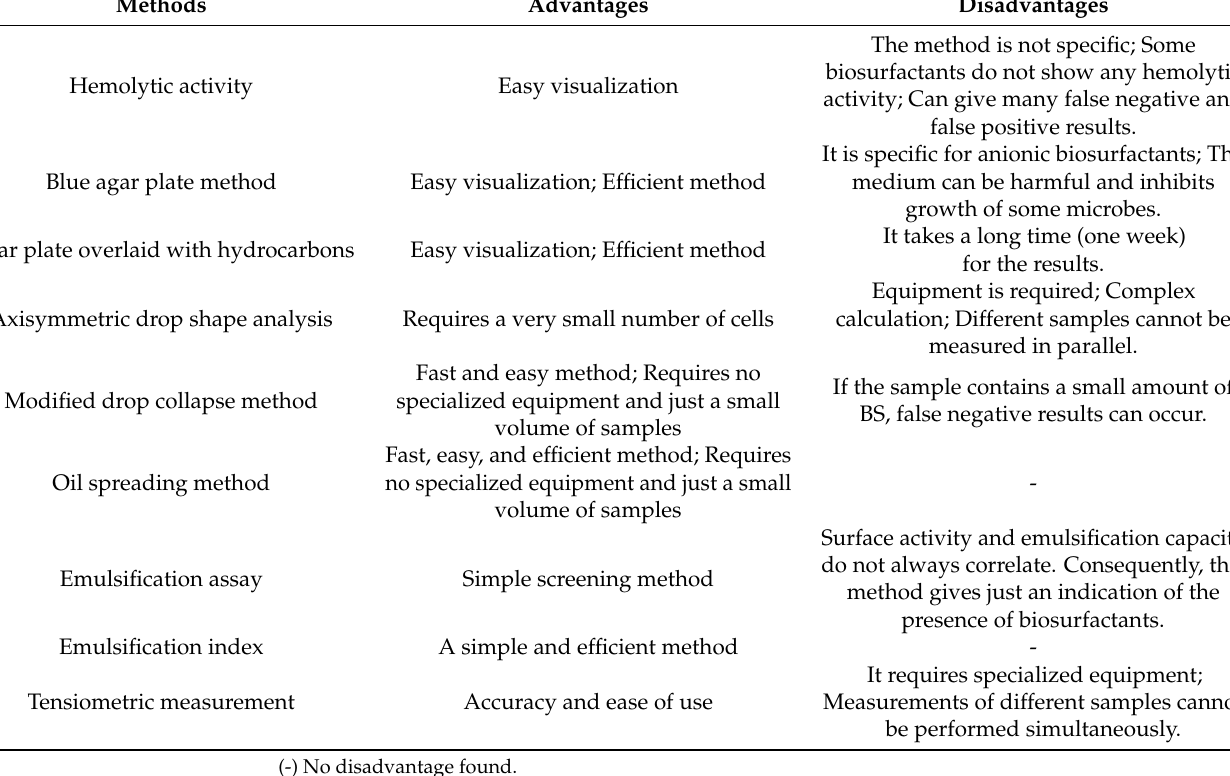
Table 2. Screening methods to evaluate potential BS-producing microorganisms and their advantages and